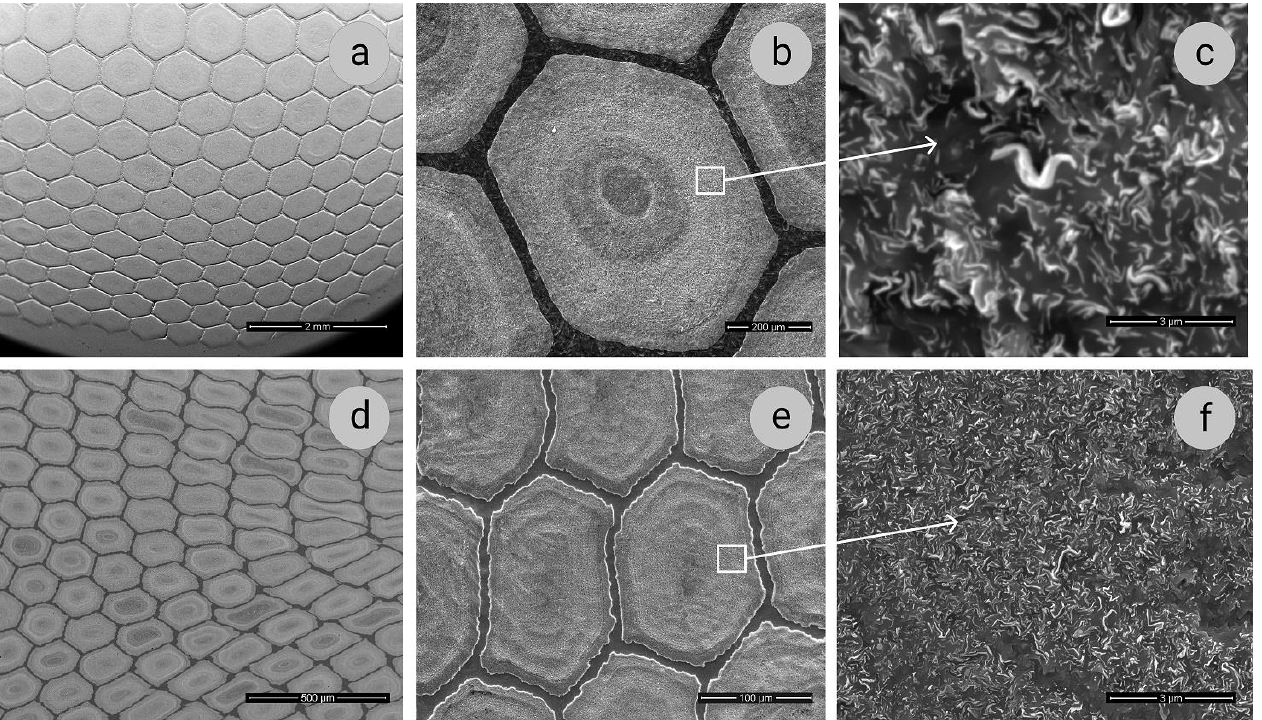
Materials 2021 , 14 , x FOR PEER REVIEW Figure 1. Transverse sections of Samples 1 ( a – c ) and 2 ( d – f ) of multicore Cu–18Nb composite (SEI images). The areas taken with higher magnification (Figure 1c,f) are denoted with squares in Figure 1b,e.